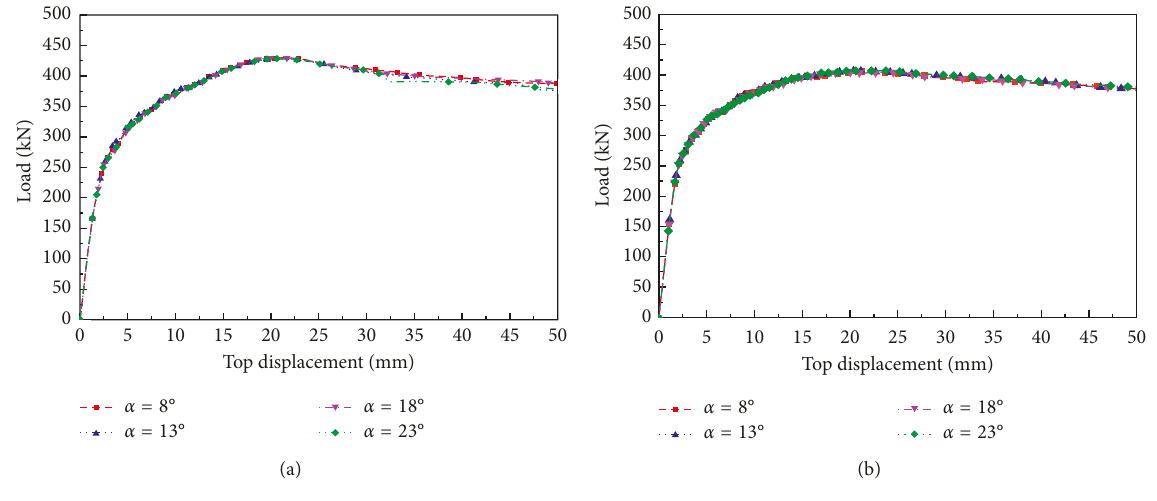
Figure 13: Slope angle sensitivity analysis: (a) W2 and (b)